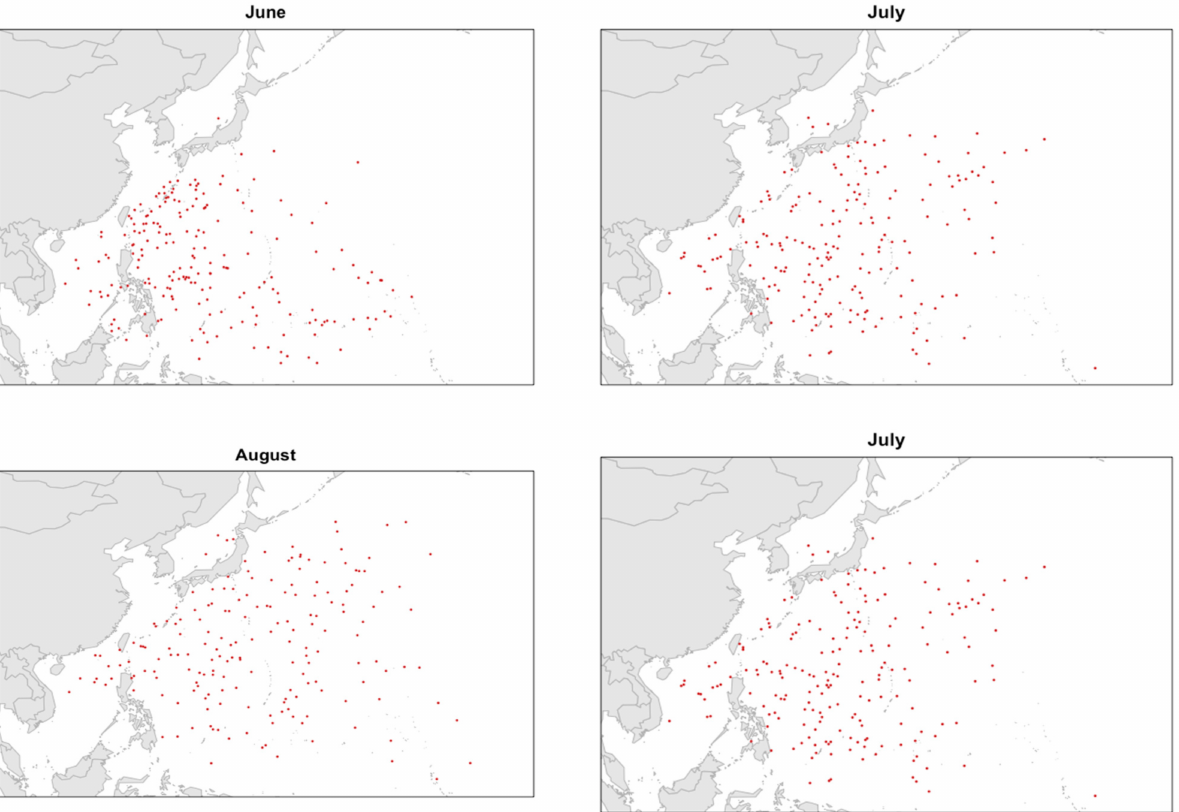
Figure 5. Modeled typhoon genesis (indicated by red dots) of WNP region in